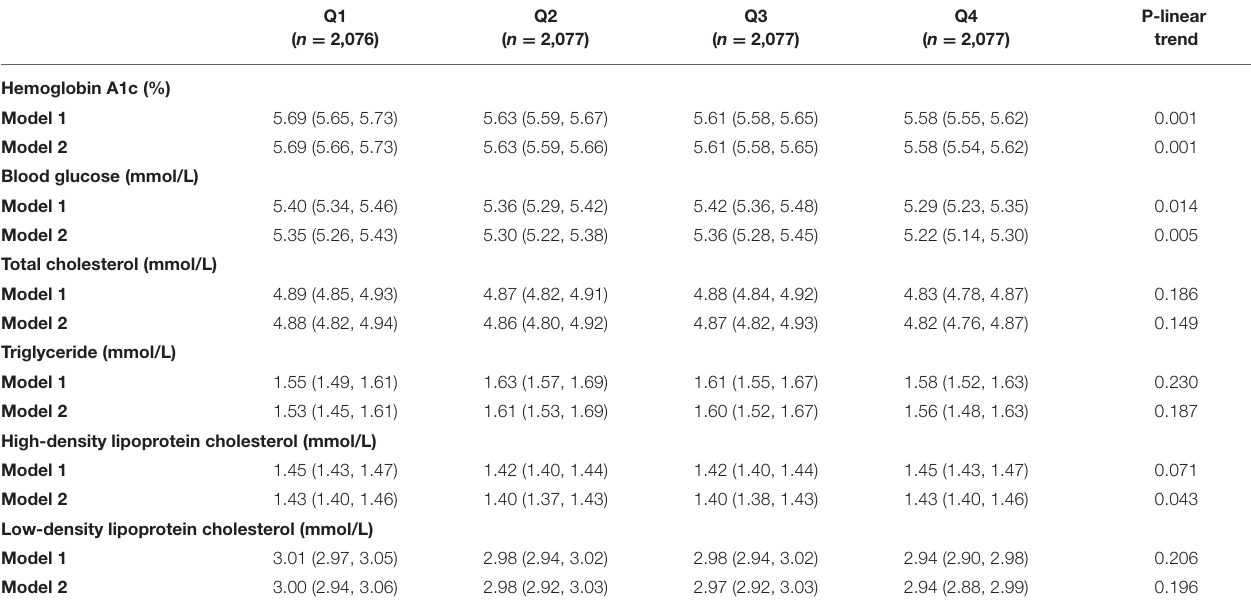
TABLE 3 | Estimation mean (95% CI) of biomarkers of glucose/lipid metabolism according to dietary vitamin C intake (mg) among